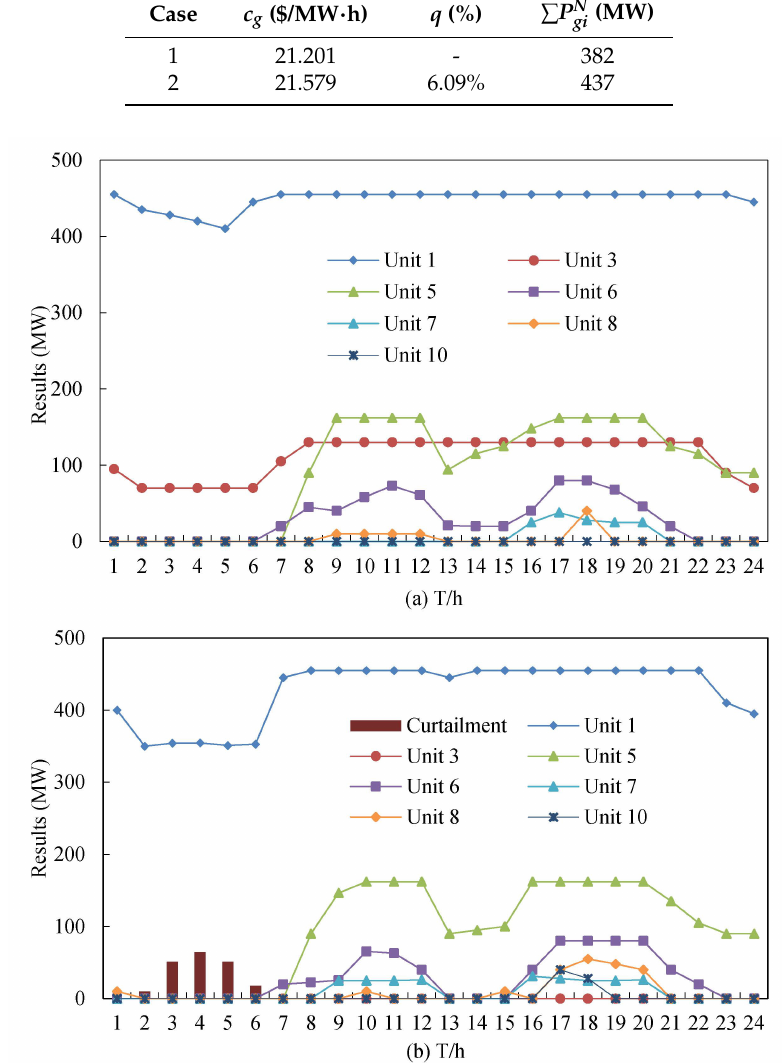
Figure 6. Scheduling results of systems without BESS; ( a ) Case1 results without wind power integration; and, ( b ) Case 2 results with wind power